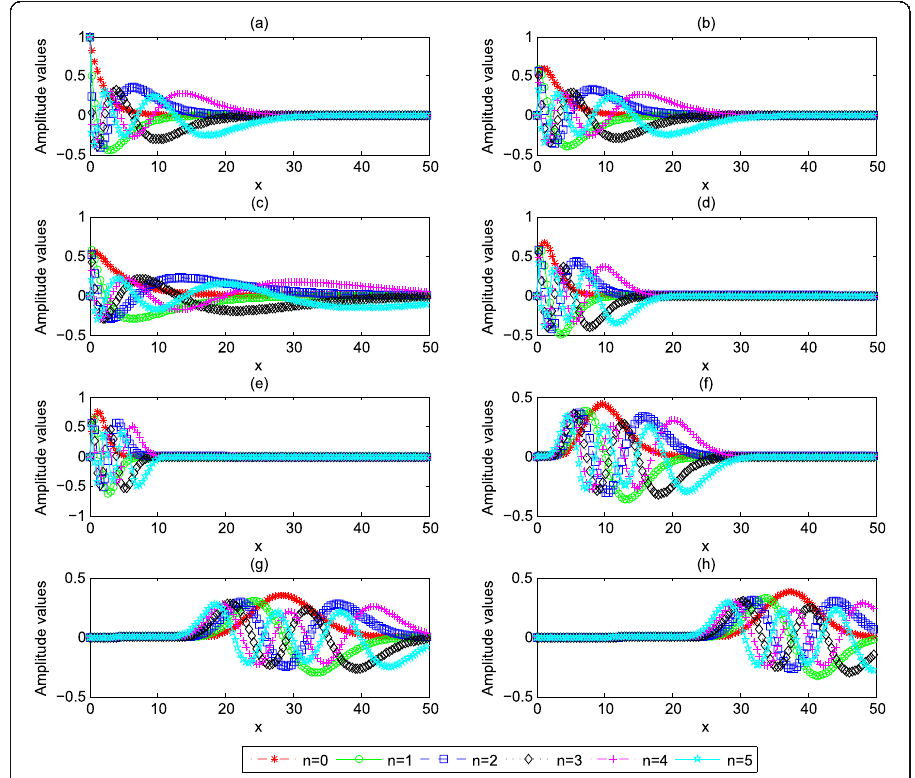
Fig. 2 Distribution curves of the NFr-GLPs under different parameter